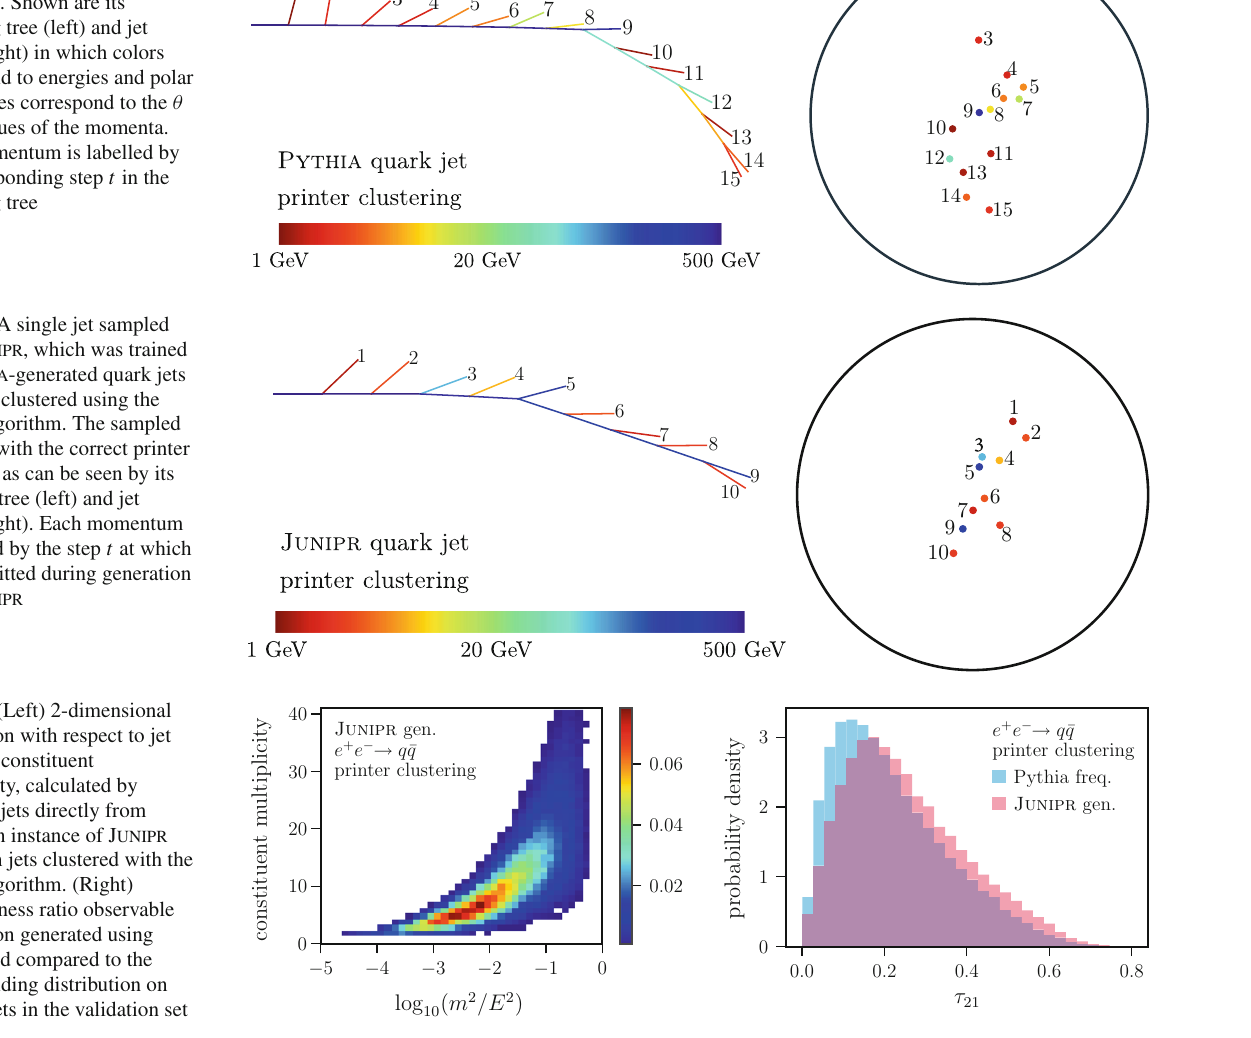
Fig. 20 A single Pythia jet clustered using the printer algorithm. Shown are its clustering tree (left) and jet image (right) in which colors correspond to energies and polar coordinates correspond to the θ and φ values of the momenta. Each momentum is labelled by its corresponding step t in the clustering tree